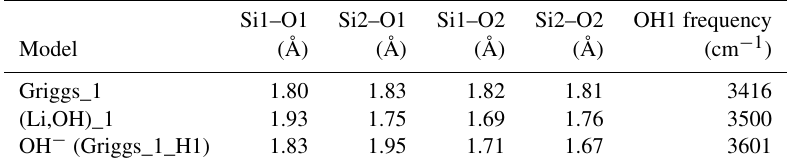
Table 2. Inter-atomic distances and stretching frequencies of OH defects with double Si–O–Si